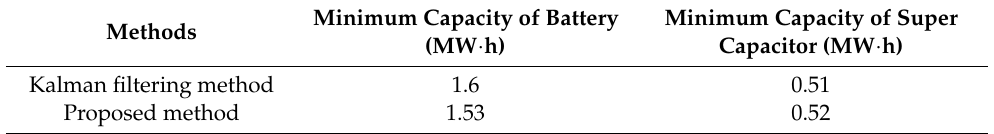
Table 3. Minimum capacity required for energy storage.